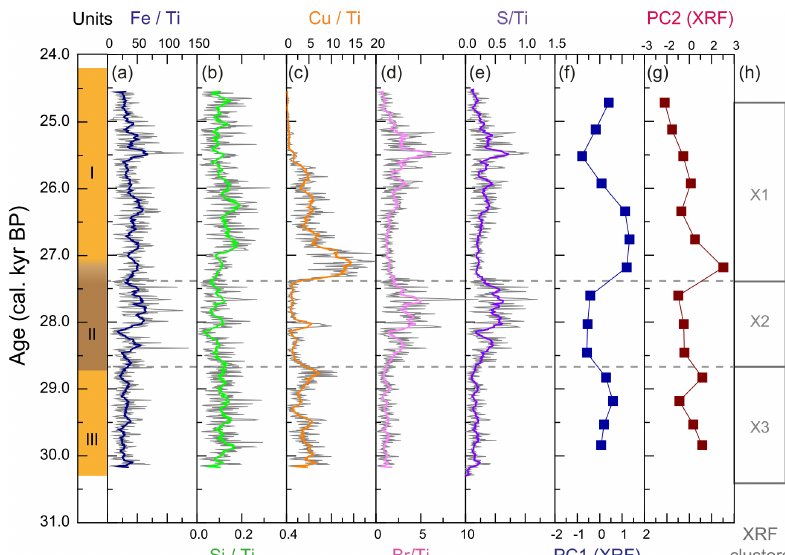
Figure 3. XRF characterization of stomach-oil deposit WMM7. All XRF data are normalized to Ti. The age model uses Holocene “no sea ice” (cid:49)R (Table 1). The ∼ 100-year smoothing is shown in coloured lines. Cluster boundaries are determined by constrained hierarchical clustering analysis in the rioja package of R (Juggins, 2020) compared to a broken-stick analysis (Bennett, 1996). Three significant clusters were identified (h) , which broadly coincide with Units I–III, noting the gradual Unit II–I boundary.